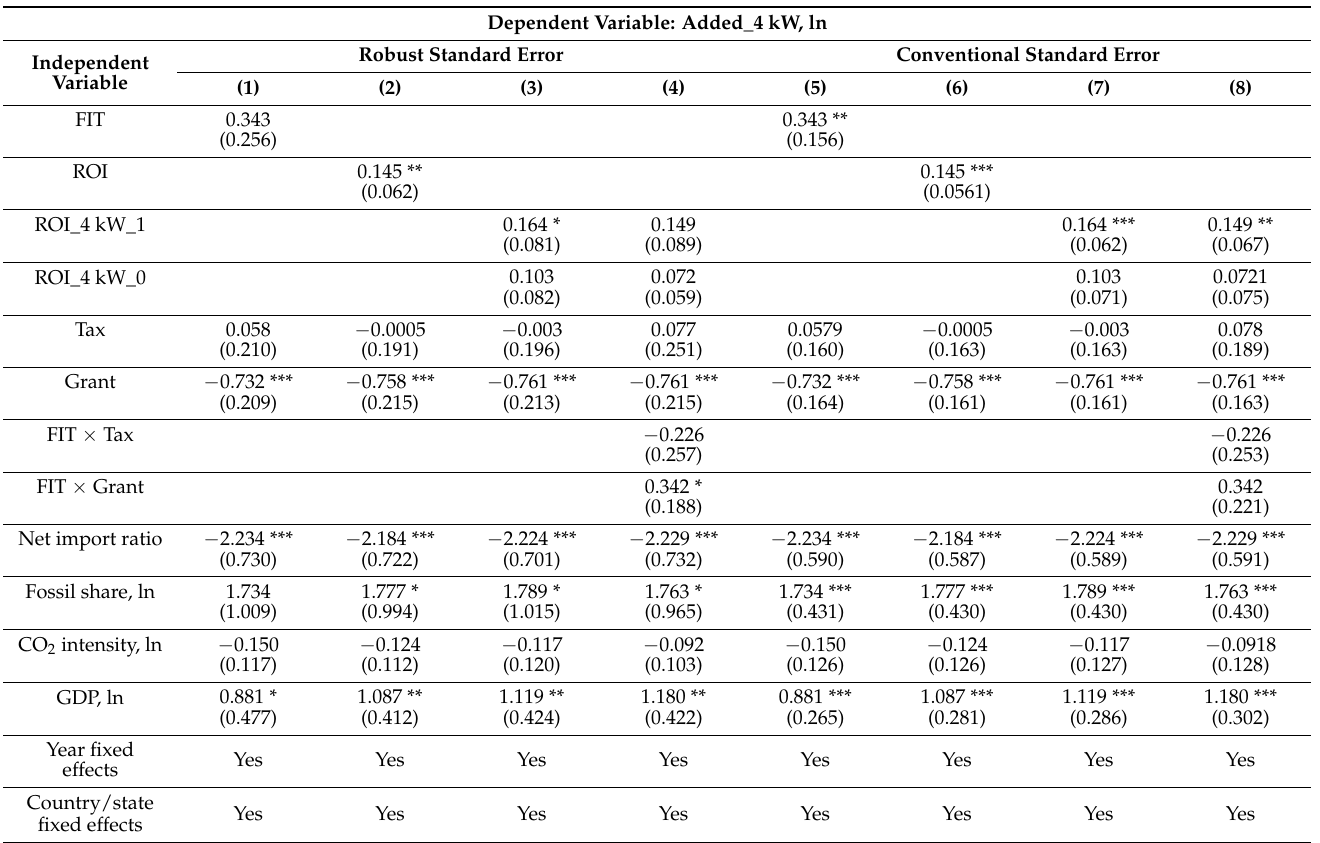
Table 1. Fixed effects estimation results for solar PV on the residential